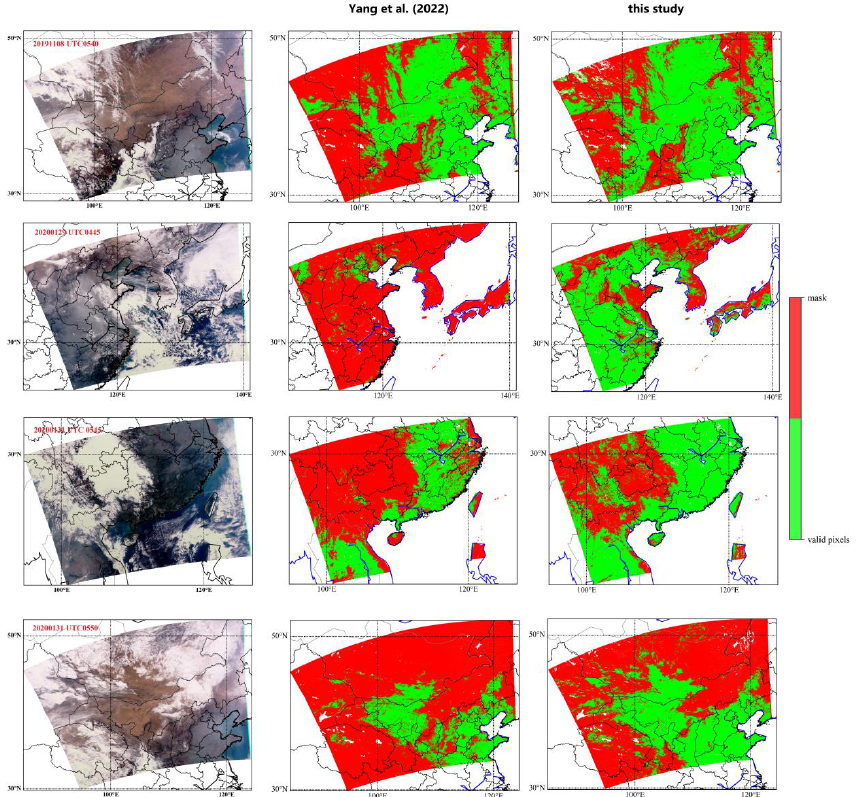
Figure 11. True color map and comparison of identified results of Yang (2022) [23] and the MHAM algorithm at UTC0540 on 8 October 2019 (the first line), UTC0445 on 29 January 2020, UTC0545 on